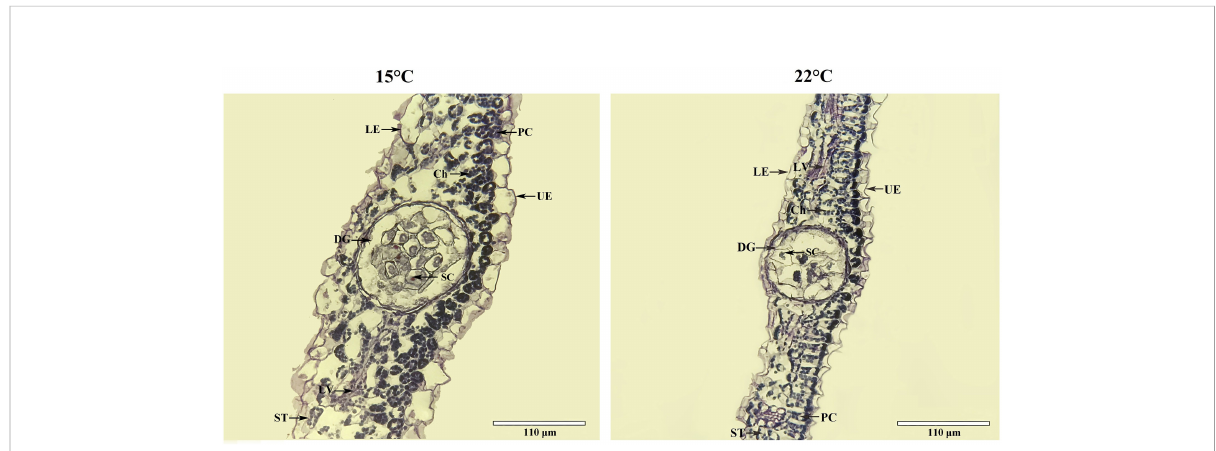
FIGURE 2 Cross-sectional micro-structure for leaves of seedlings grown at 15 and 22°C. Ch, chloroplast, DG, dark gland, LE, lower epidermis, LV, leaf veins, PC, palisade cell, SC, secretory cell, ST, spongy tissue, UE, upper